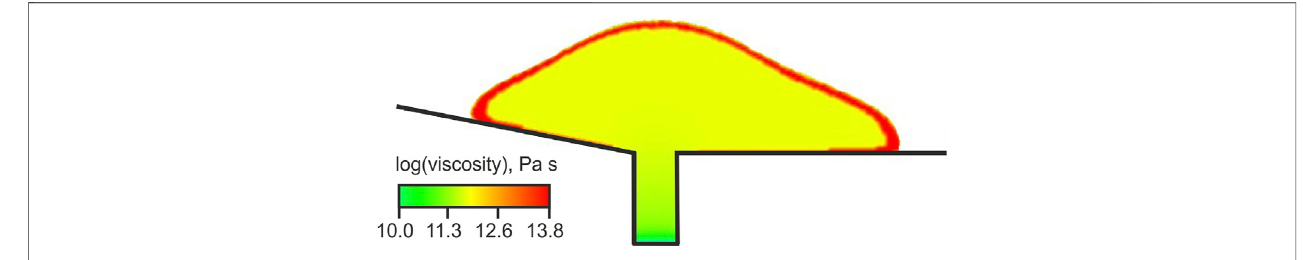
FIGURE A1 | A layer (red) of the higher viscosity introduced in numerical experiment 10 to simulate a dome carapace.